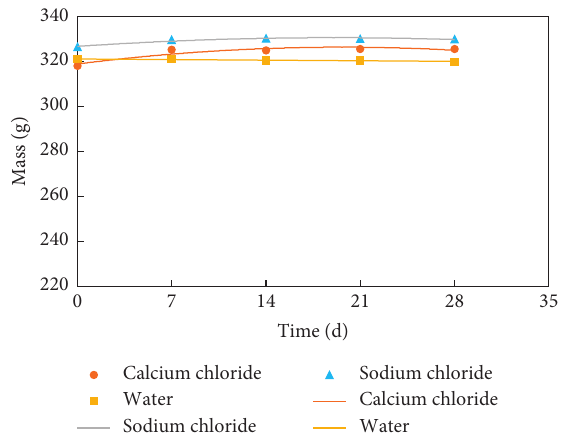
Figure 10: Mass change of the cuboid specimen of HWC materials in different solutions.